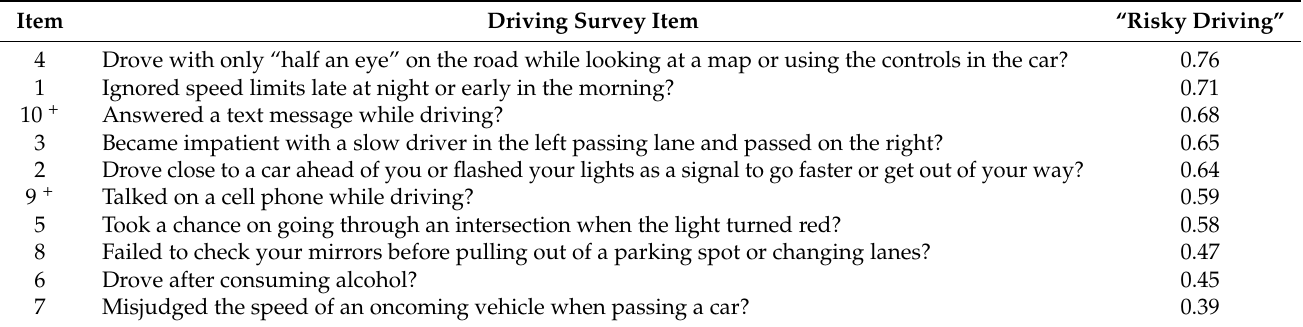
Table 3. Standardized item loadings on the single factor structure of risky driving